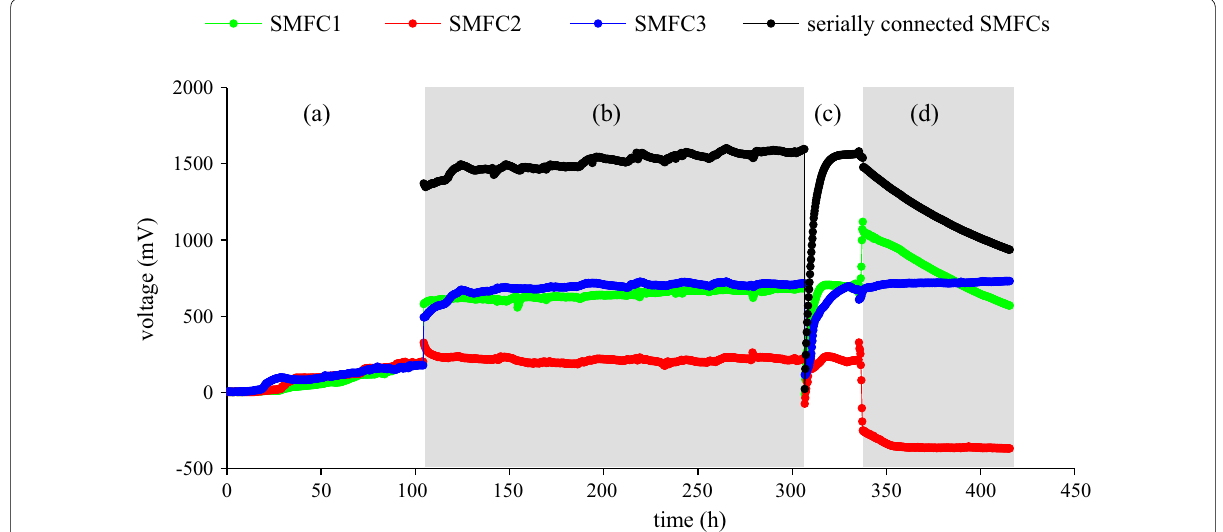
Fig. 2 Voltage curve of SMFCs in four stages including a acclimation, b serially connection, c charging a capacitor, and d running a timer